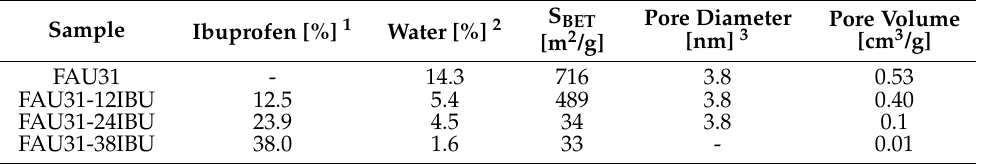
Table 1. Mass % of ibuprofen, water, specific surface areas (S BET ), pore diameters, and pore volumes of the samples under